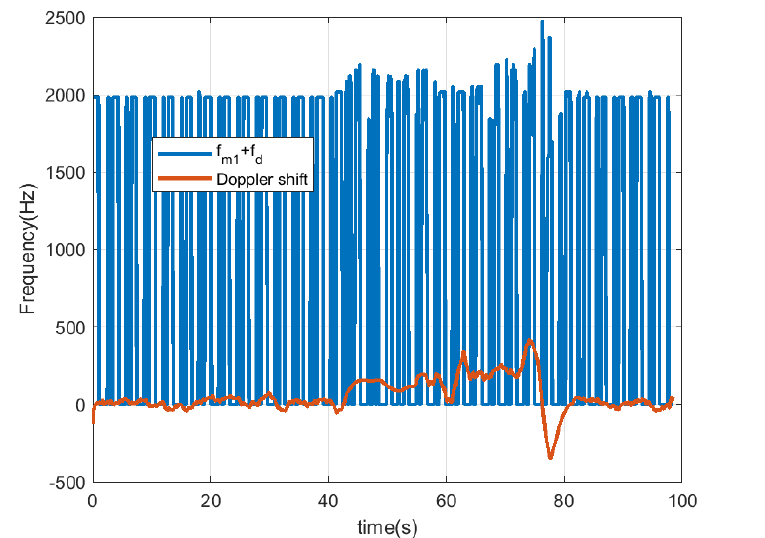
Figure 25. Data measurement using length 7 Barker codes when the scooter is in motion: scooter Doppler frequency estimate and detected frequency for bit 1. The scooter is within the radar reading range at any